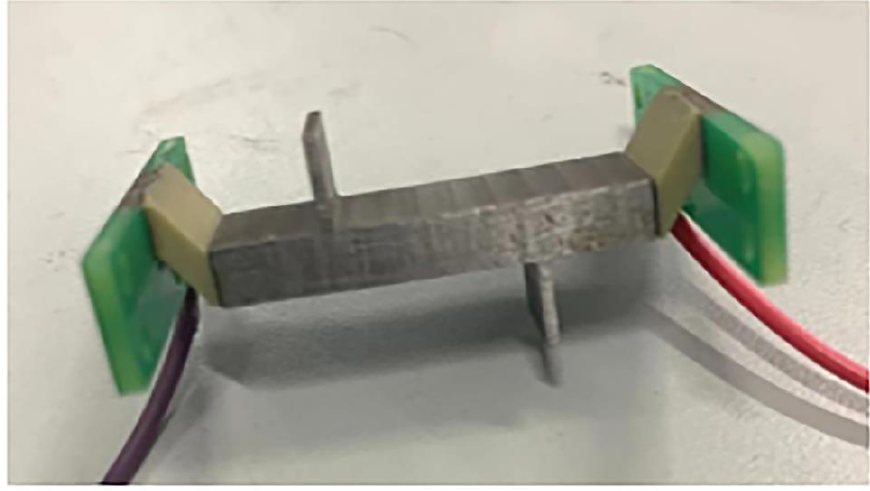
Figure 9. The stator of the motor.